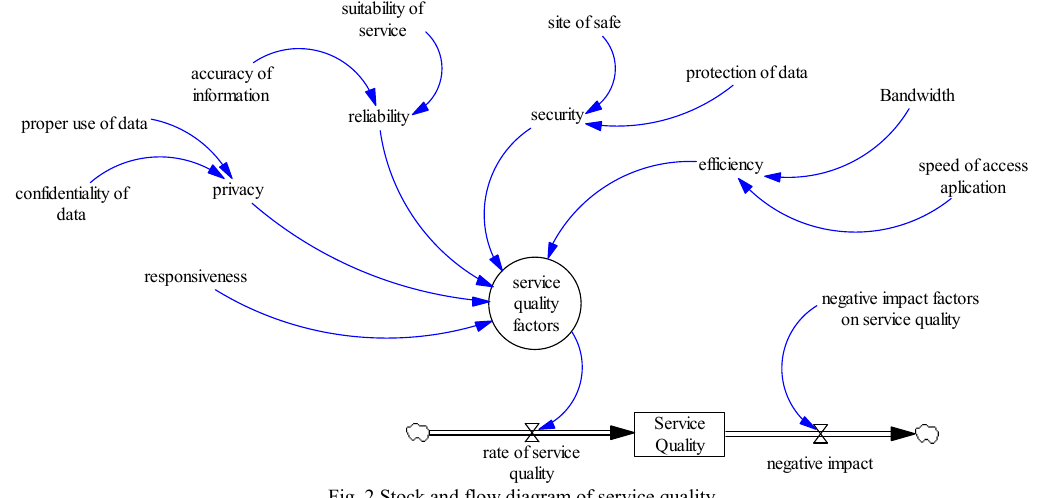
Fig. 2 Stock and flow diagram of service quality